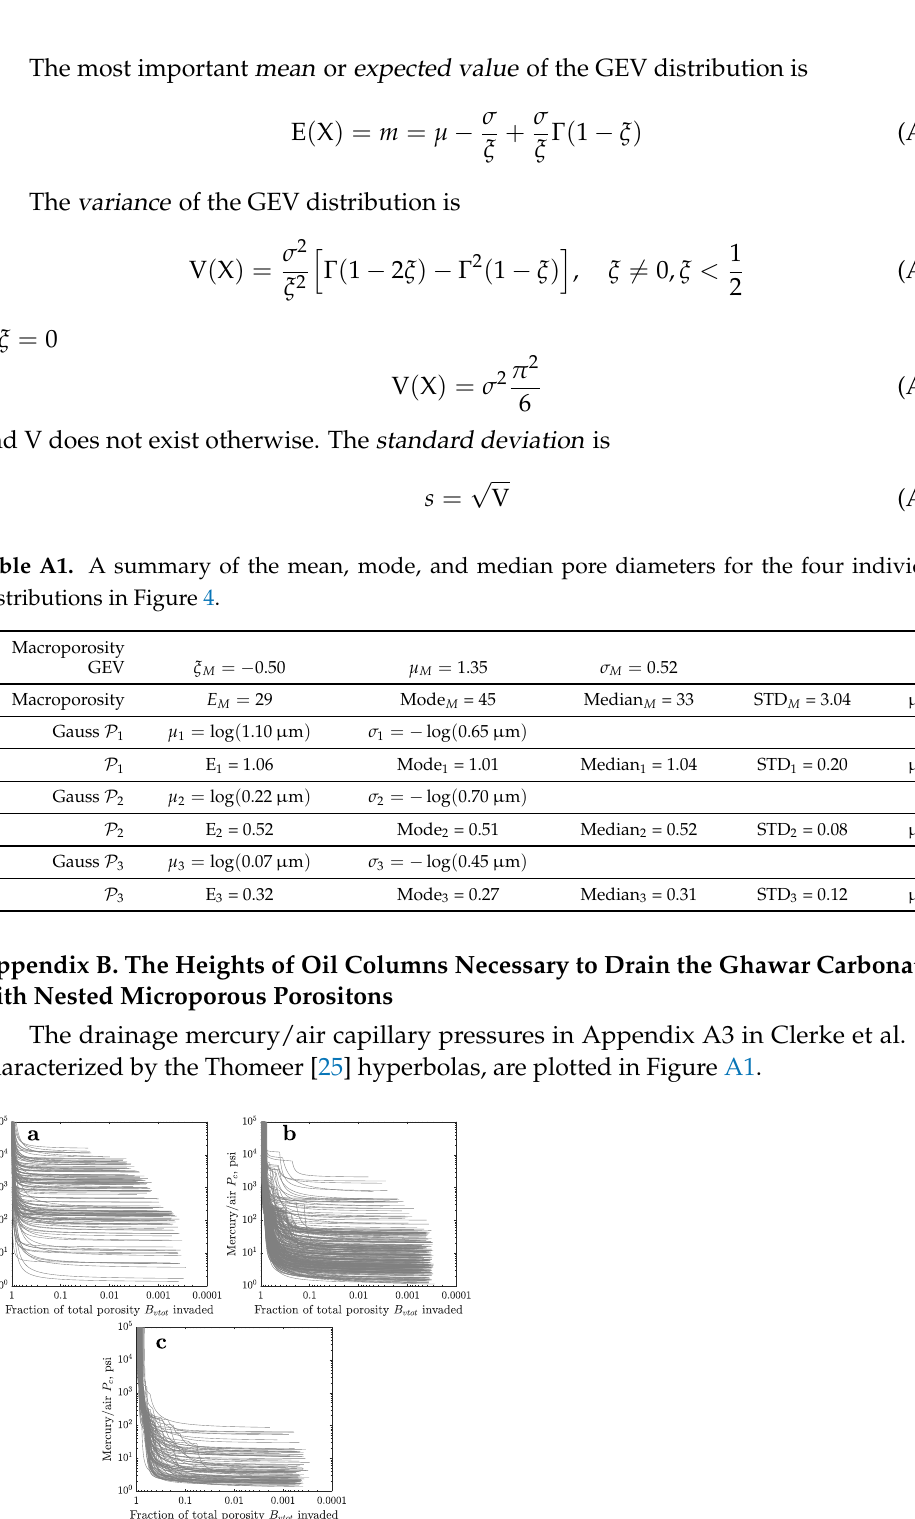
Figure A1. ( a ) The MICP curves for the rock samples the are described by a single Thomeer hyperbola (Porositon 1 in Porositon M ). ( b ) The MICP curves for the rock samples the are described by two Thomeer hyperbolas (Porositon 2 in Porositon 1 in Porositon M). ( c ) The MICP curves for the rock sam- ples are described by three Thomeer hyperbolas (Porositon 3 in Porositon 2 in Porositon 1 in Porositon M). B v is the infinite pressure extrapolation of the sample porosity occupied by mercury that results from a single Thomeer hyperbola. BV = vtot is the sum of all B v s of multiple Thomeer